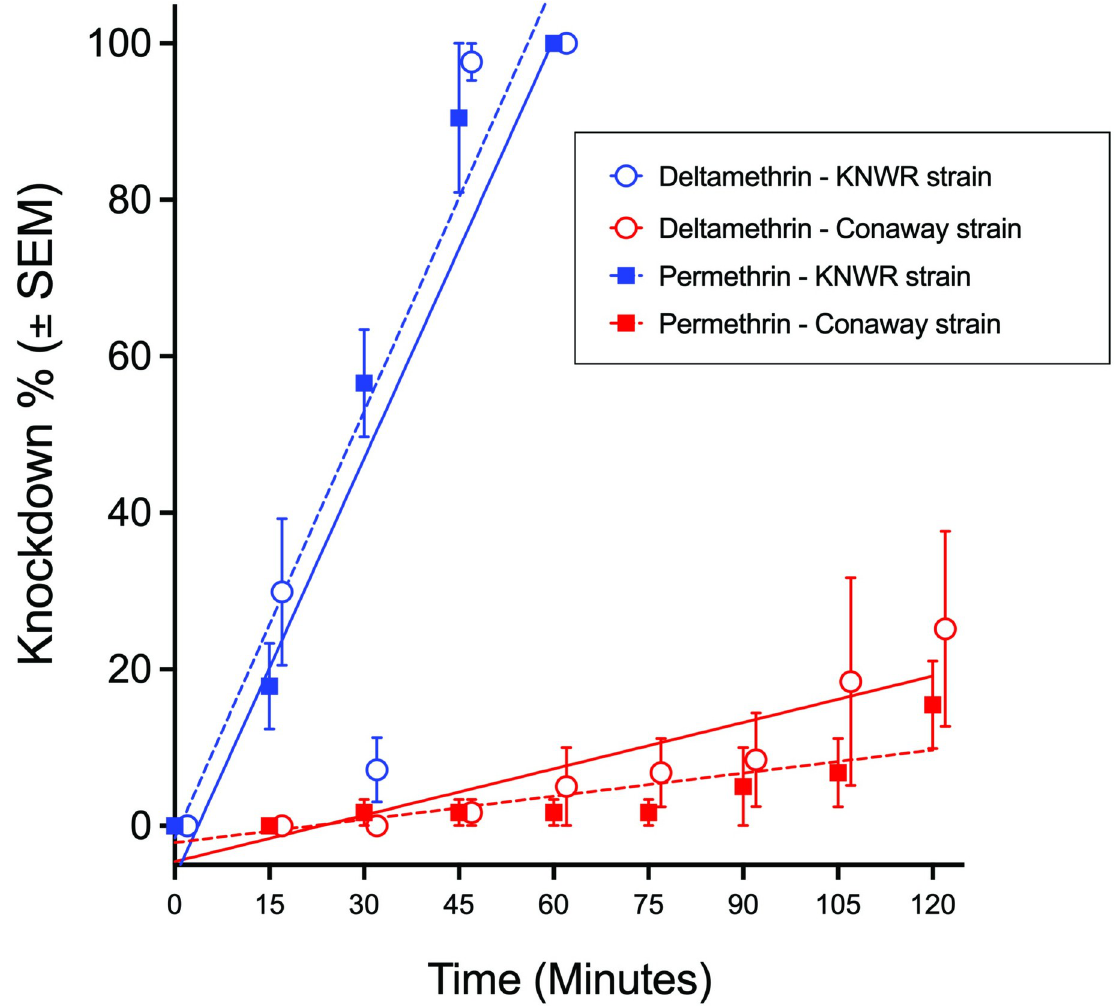
Fig 4. Bottle bioassay of Cx . tarsalis strains KNWR and Conaway with permethrin or deltamethrin. Closed squares indicate bottle bioassays using permethrin and open circles indicate deltamethrin bottle bioassays. Blue symbols and regression lines denote bottle bioassays with KNWR strain Cx . tarsalis , and red symbols and regression lines indicate bottle bioassays with Conaway strain Cx . tarsalis . Deltamethrin symbols are offset by 2 min for clarity. Equation of lines: Deltamethrin: susceptible KNWR strain, Y = 1.785–X—6.627 (R 2 =